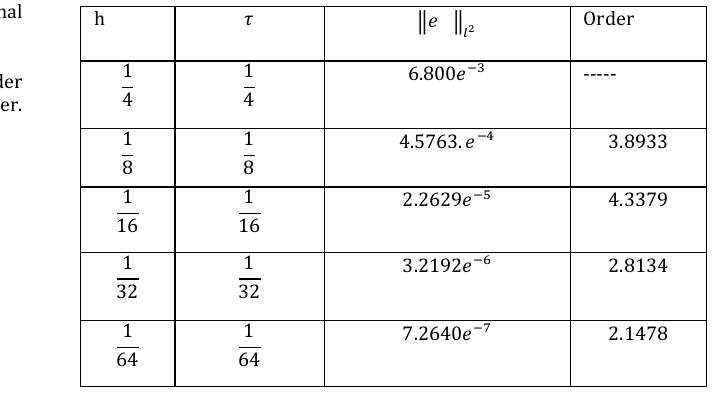
(Test Problem 2) Error norm, the accuracy order of the scheme for different value of 𝛾𝛾